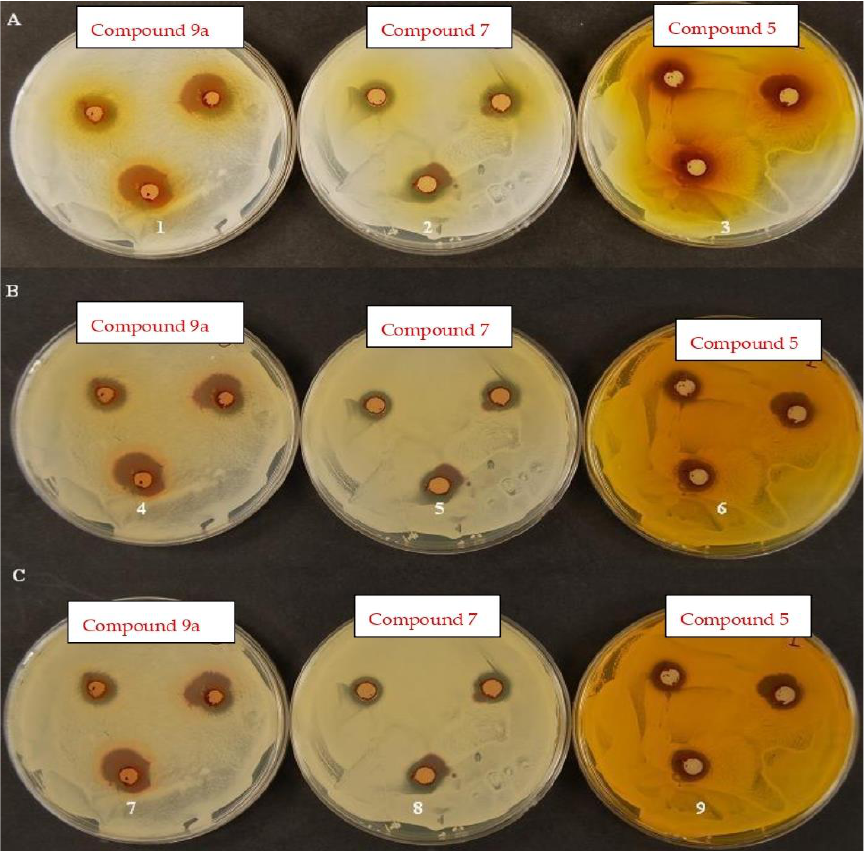
Figure 12. Candida albican treated with 10mg ml −1 of dyes 5, 7, and 9a after one day ( A ) (1, 2, 3), three Figure 12. Bacillus subtilus treated with 10mg ml − 1 of dyes 5, 7, and 11a after one day ( A ) (1, 2, 3), days( B ) (4, 5, 6) and six days ( C ) (7, 8, 9) of incubation. three days( B ) (4, 5, 6) and six days ( C ) (7, 8, 9) of While, the cytostatic effect of the same dyes is clear on the plates inoculated with Bacillus subtilus. The growth of B. subtilus resumed in the inhibited area after six days of incubation, which may indicate that as the concentration/toxicity of dyes number 5, 7 and 9a reduce due to possible evaporation of these dyes or diffusion in the media, the effect of these dyes on B. subtilus decrease, and the organisms start growing again (Figure 13).